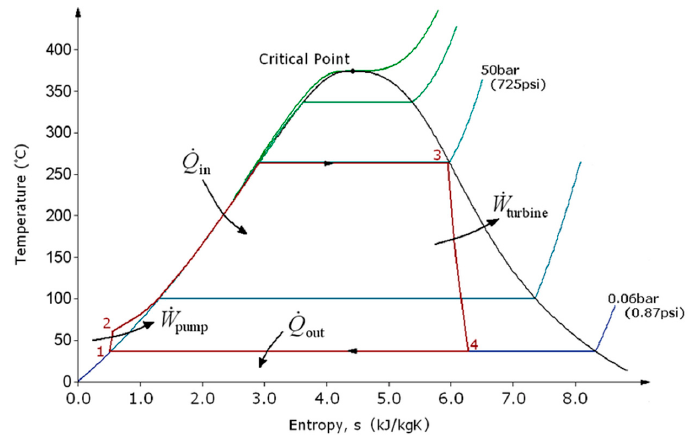
Figure 1. Temperature and entropy (T-S) diagram (modified from [23]). ( Process 1–2 : The working fluid is pumped from low to high pressure. As the fluid is a liquid at this stage, the pump requires little input energy. Process 2–3 : The high-pressure liquid enters a boiler, where it is heated at constant pressure by an external heat source to become a dry saturated vapor. The input energy required can be easily calculated graphically, using an enthalpy-entropy chart (h–s chart, or Mollier diagram), or numerically, using steam tables. Process 3–4 : The dry saturated vapor expands through a turbine, generating power. This decreases the temperature and pressure of the vapor, and some condensation may occur. The output in this process can be easily calculated using the chart or tables noted above. Process 4–1 : The wet vapor then enters a condenser, where it is condensed at a constant pressure to become a saturated